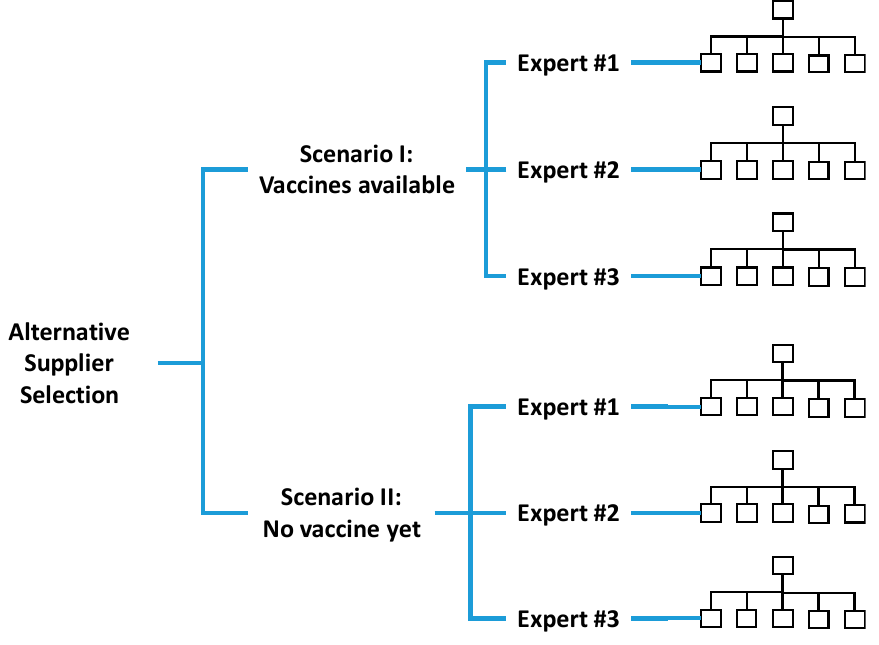
Figure 7. The scenario-based multi-criteria decision-making problem. The pairwise comparison results by the three experts in the two scenarios are summa- rized in Table